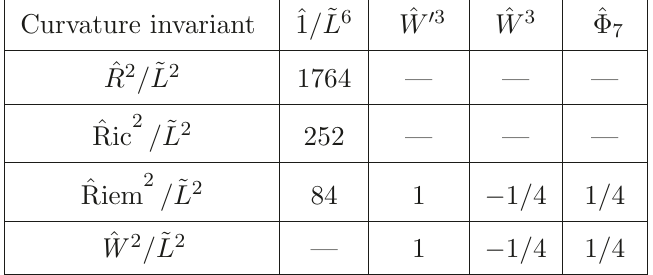
Table 3 . 7D basis of quadratic curvature invariants.